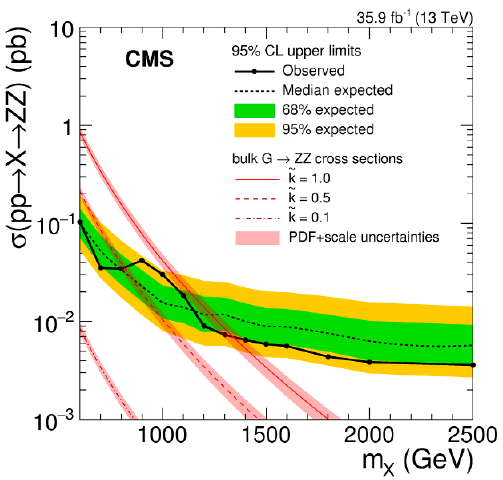
Figure 5 . Expected and observed limits on the product of cross section and branching fraction of a new spin-2 heavy resonance X ! ZZ, assuming zero width, based on the combined analysis of the electron and muon channels. Expectations for the production cross section (cid:27) (pp ! X ! ZZ) are also shown for the benchmark bulk graviton model for three values of the curvature scale parameter ~ k